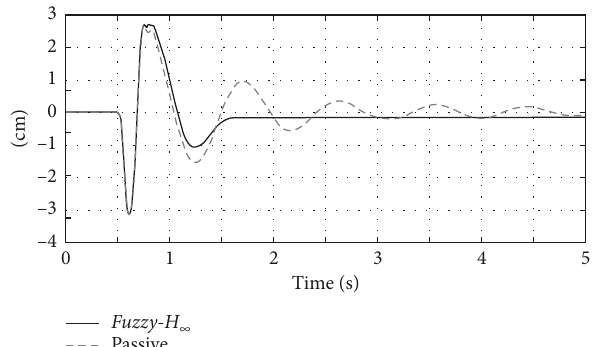
Figure 10: Front suspension’s deflection ( Z